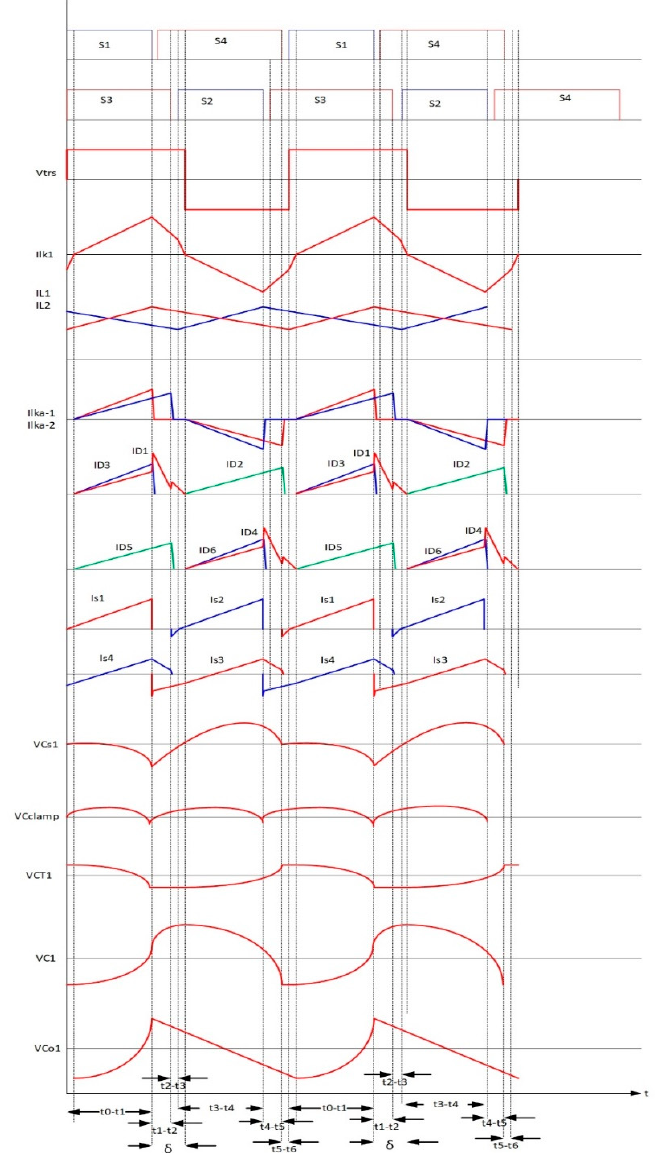
Figure 7. Waveforms of the converter over a complete cycle.